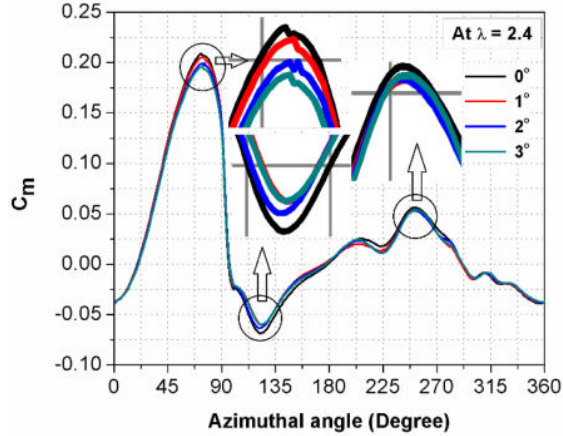
Figure 9. Variations of C m with θ for different degree of blade twist turbine.